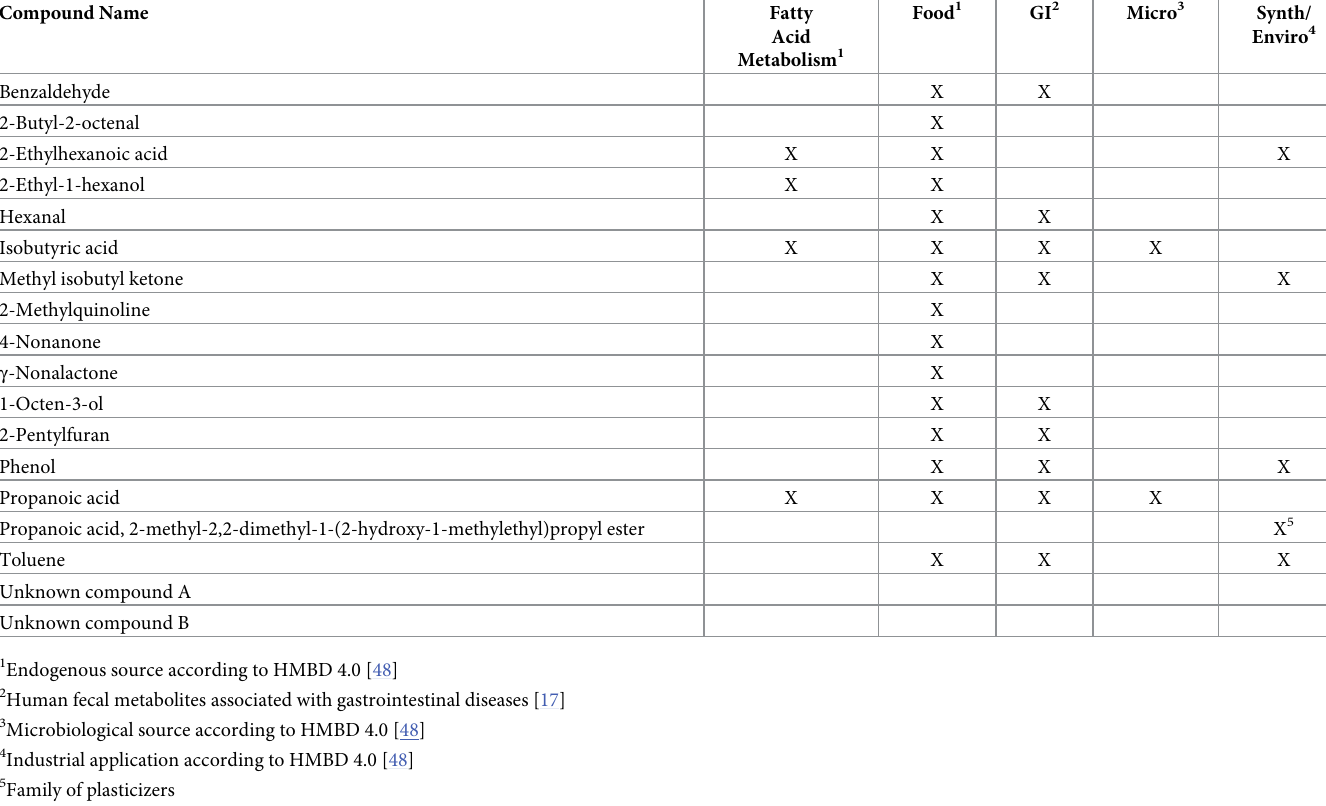
Table 3. Natural origin of metabolites associated with rabies volatile fecal